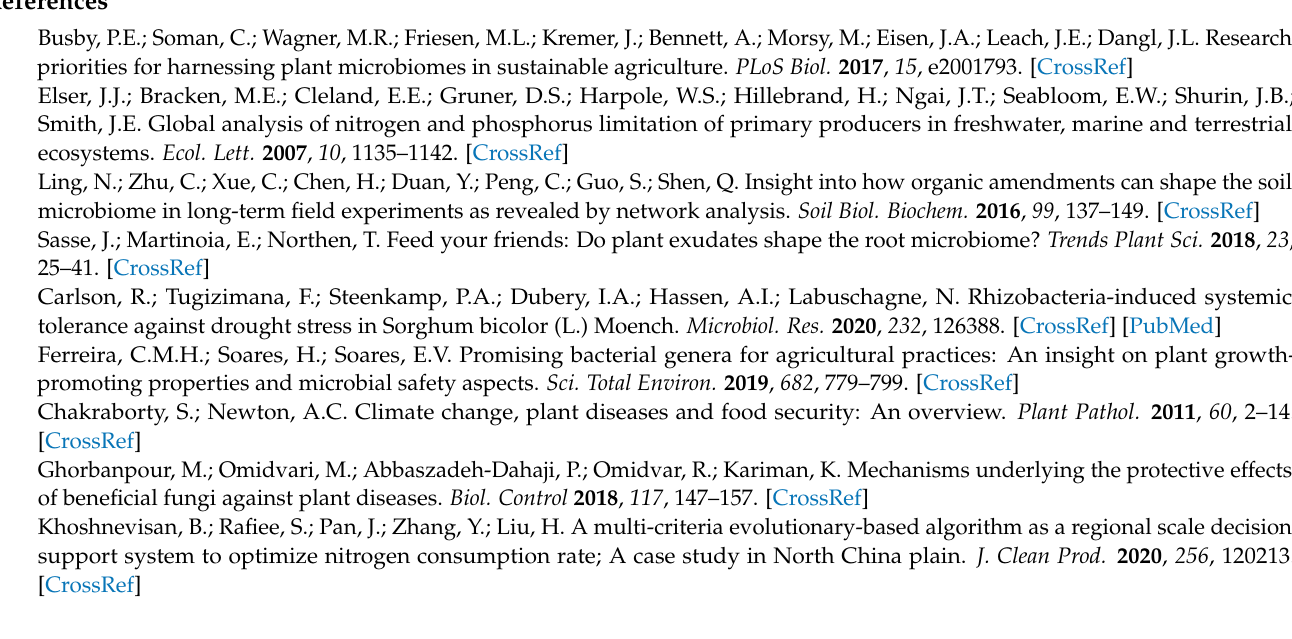
among different treatments. Table S1: Soil conditions of the field experiment, Table S2: Statistics of the sequencing results, Table S3: Bray-Curtis results, Table S4: PERMANOVA results of bacterial communities treated by different treatments, Table S5: Statistic results of LefSe analysis, Table S6: Relative abundance of top40 genera, Table S7: OUT table, Table S8: The yields of maize in different